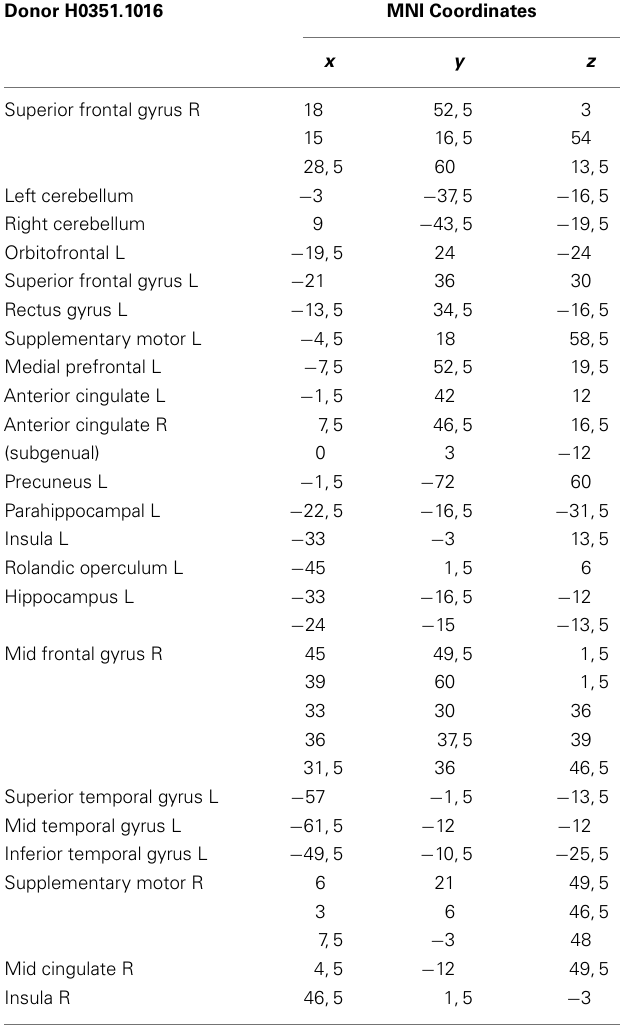
Table 5 | Overlap brain sites between the ERCC8 gene expression of Donor H0351.1016 from theAllen Brainmap and CS patient atrophy